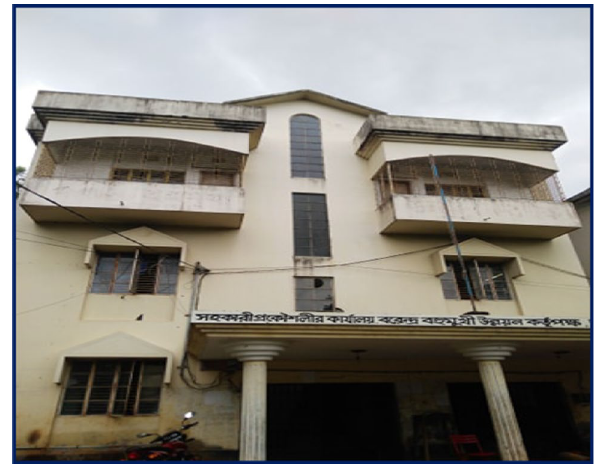
Fig. 6 BMDA Office Building at Tanore upazila under Rajshahi dis-